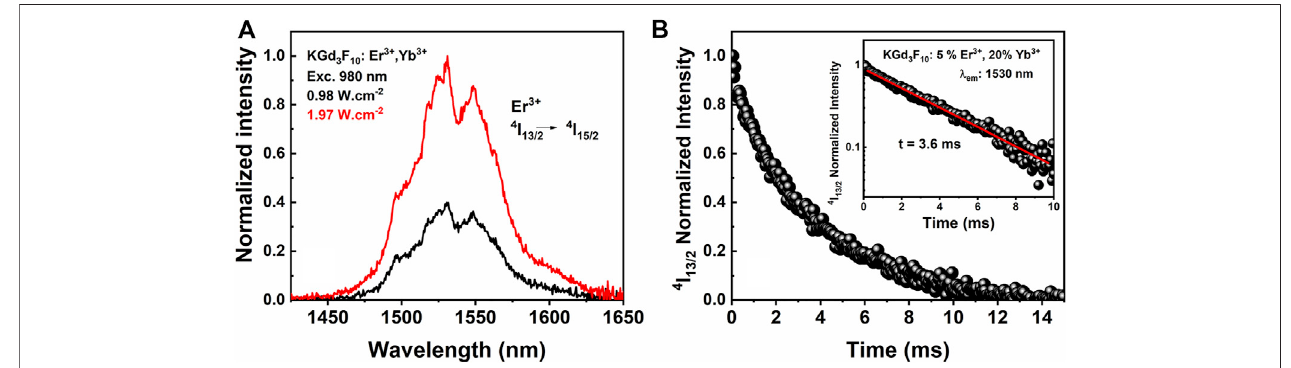
FIGURE 7 | Photoluminescence spectra in the 1,550 nm range assigned to the 4 I 13/2 → 4 I 15/2 transition upon excitation at 980 nm for different power densities (A) and decay curve from the 4 I 13/2 metastable level under excitation at 273 nm (B) of the 5% Er 3+ , 20% Yb 3+ : KGd 3 F 10 NP powder.